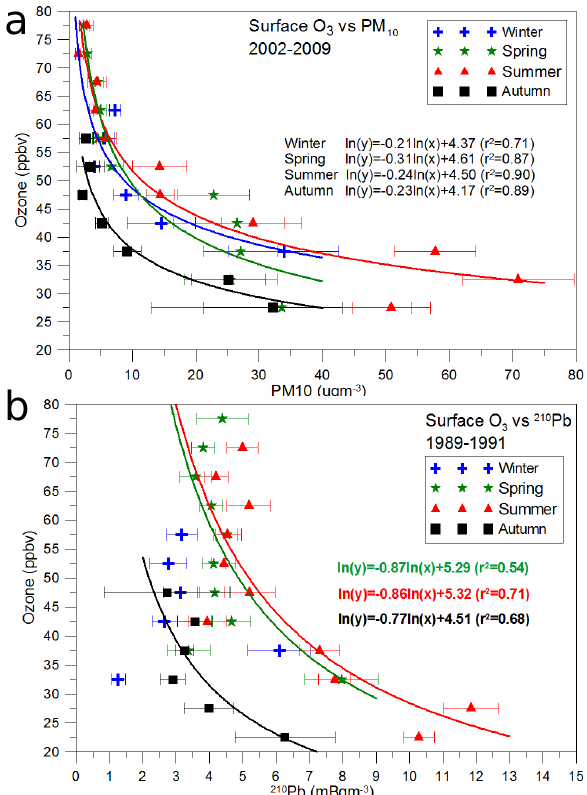
Fig. 7. (a) Monthly mean percentage of air mass types arriving to Fig. 7. (a) monthly mean percentage of air mass types arriving to Fig. 7. (a) monthly mean percentage of air mass types arriving to IZO for O 3 < P25th for the period 1988–2009. (b) Monthly mean IZO for O 3 < P 25th for the period 1988–2009. (b) monthly mean IZO for O 3 < P 25th for the period 1988–2009. (b) monthly mean percentage of air mass types arriving to IZO for O 3 > P75th for the percentage of air mass types arriving to IZO for O 3 > P 75th for the percentage of air mass types arriving to IZO for O 3 > P 75th for the period 1988–2009 (bottom panel). period 1988–2009 (bottom panel). period 1988–2009 (bottom panel).